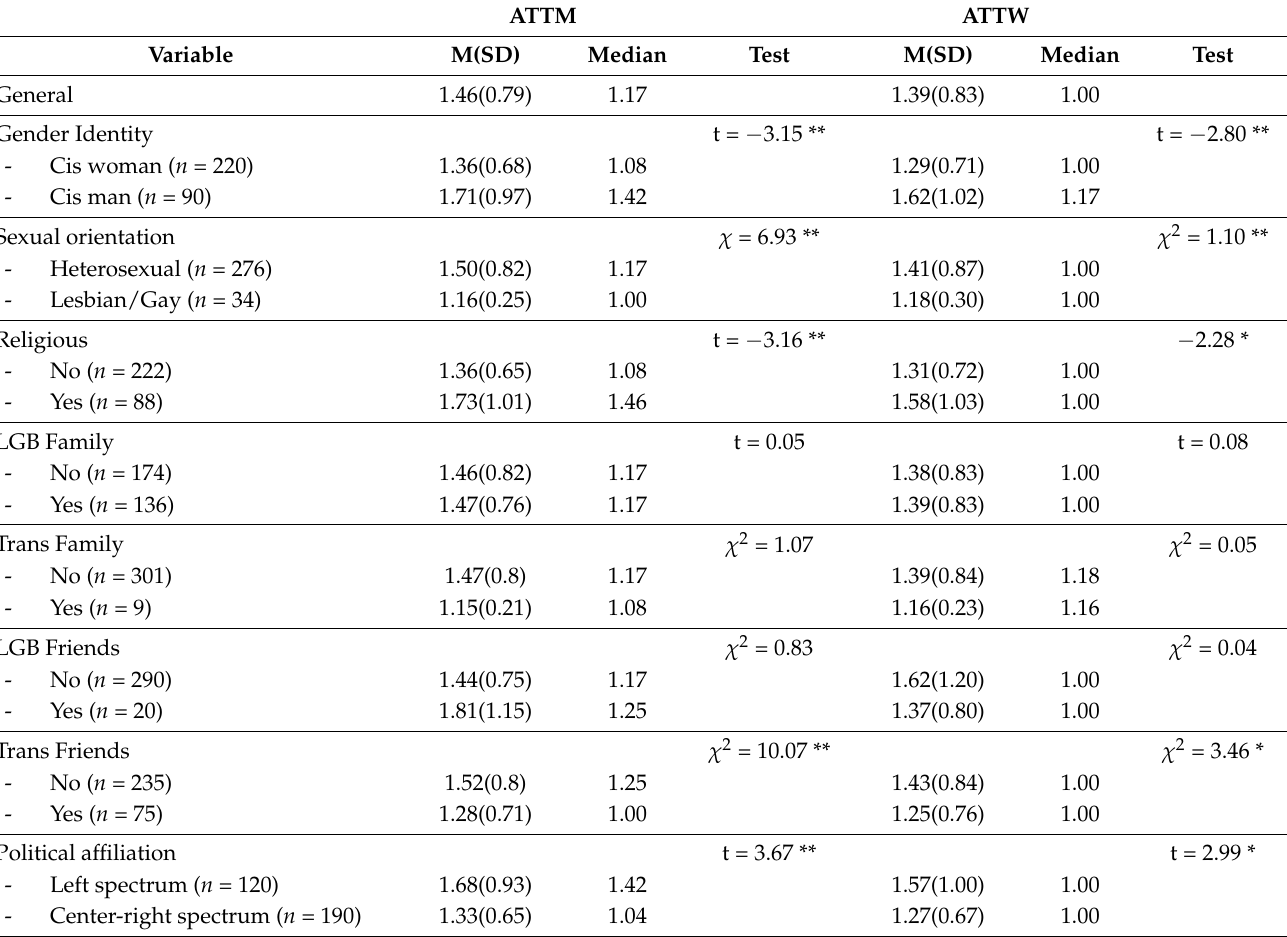
Table 3. Differences between Sociodemographic Variables in ATTM and ATTW. ATTM